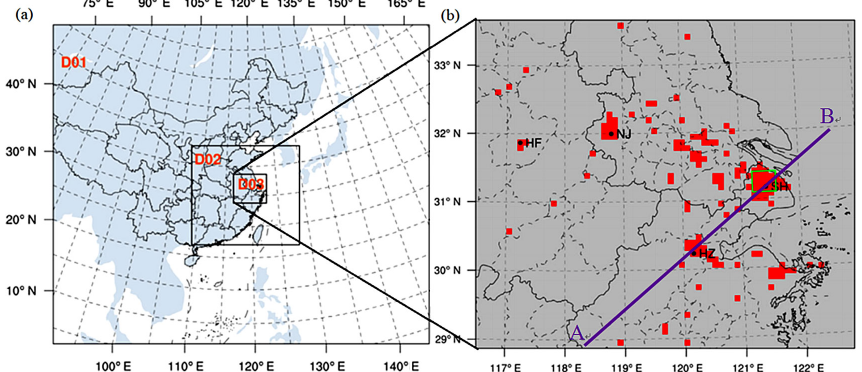
Figure 2. The three nested modeling domains (a) and MODIS urban land-use category data set used in D03, with the locations of the four meteorology observation sites (b) . SH, HZ, NJ and HF in panel (b) represent Shanghai, Hangzhou, Nanjing and Hefei, respectively. Line AB denotes the location of the vertical cross section used in Figs. 9 and